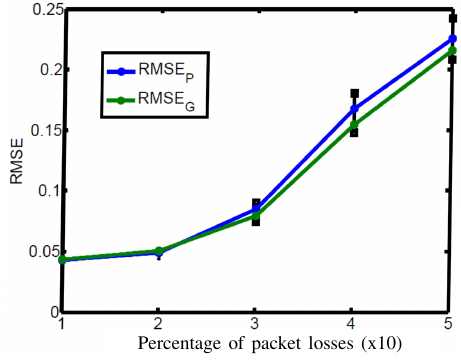
Figure 10. RMSE relation with of the ratio of losses.